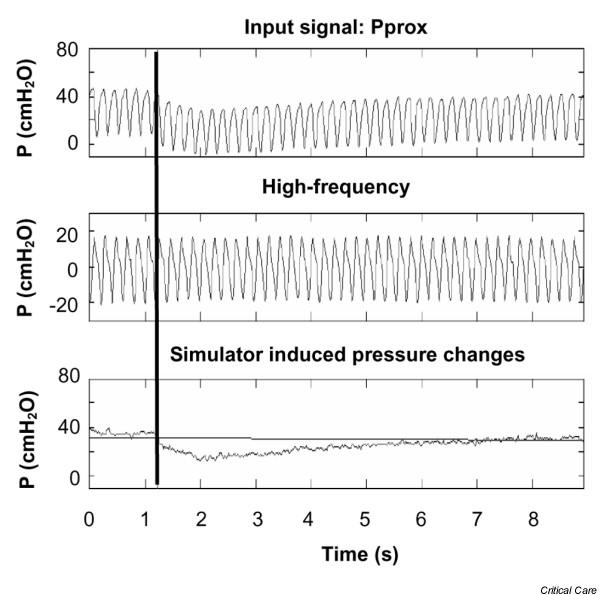
Recording during an inspiration with continuous fresh gas flow. Top panel: pressure signal sampled at airway opening (proximal airway pressure (Pprox)). Middle panel: computed high frequency component of the pressure signal, test lung influence eliminated. Bottom panel: computed test lung induced pressure changes. The vertical line denotes the start of simulated induced inspiration. The horizontal line in the bottom panel represents set mean Pprox. The curve represents fluctuation of set mean Pprox on account of breathing.